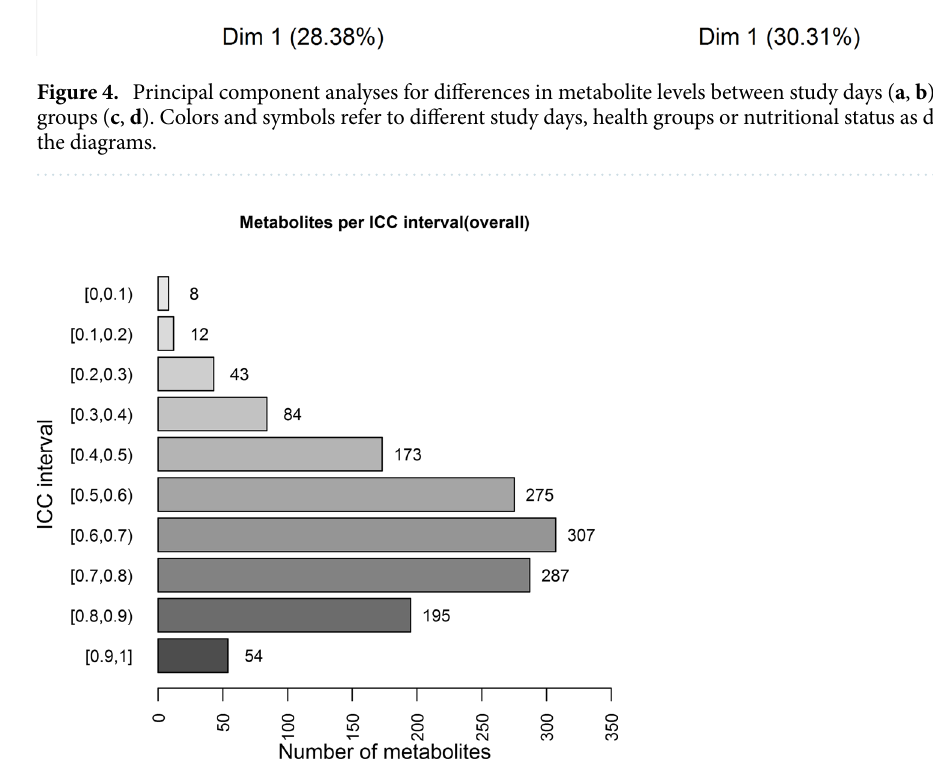
Figure 5. Histogram showing the number of individual metabolites per ICC